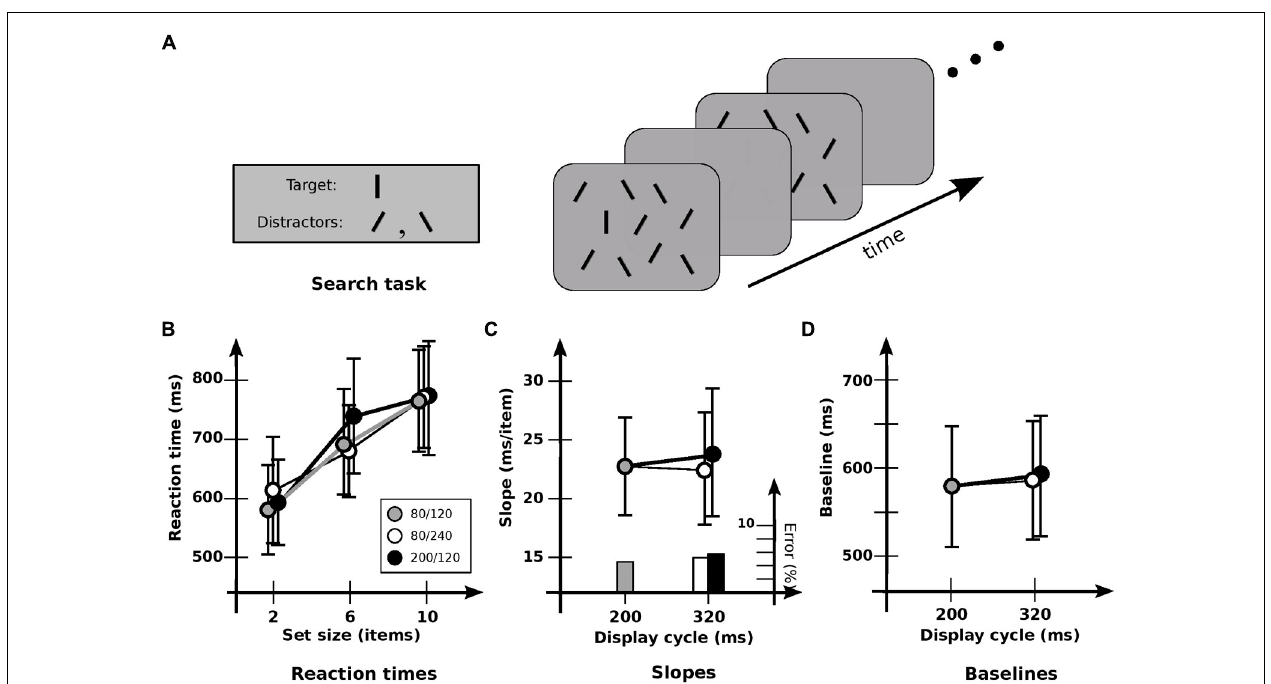
since these are target-present slopes from a presumably self-terminating search, the search speed itself is obtained by multiplying by a factor of about 2.The resultant speeds are about 50 ms/item, similar to those found elsewhere. (D) Data recast as baselines.Values for the base cadence (564 ms) are not significantly affected by an increase in off-time (576 ms) or on-time (580 ms). Error bars indicate standard error of the